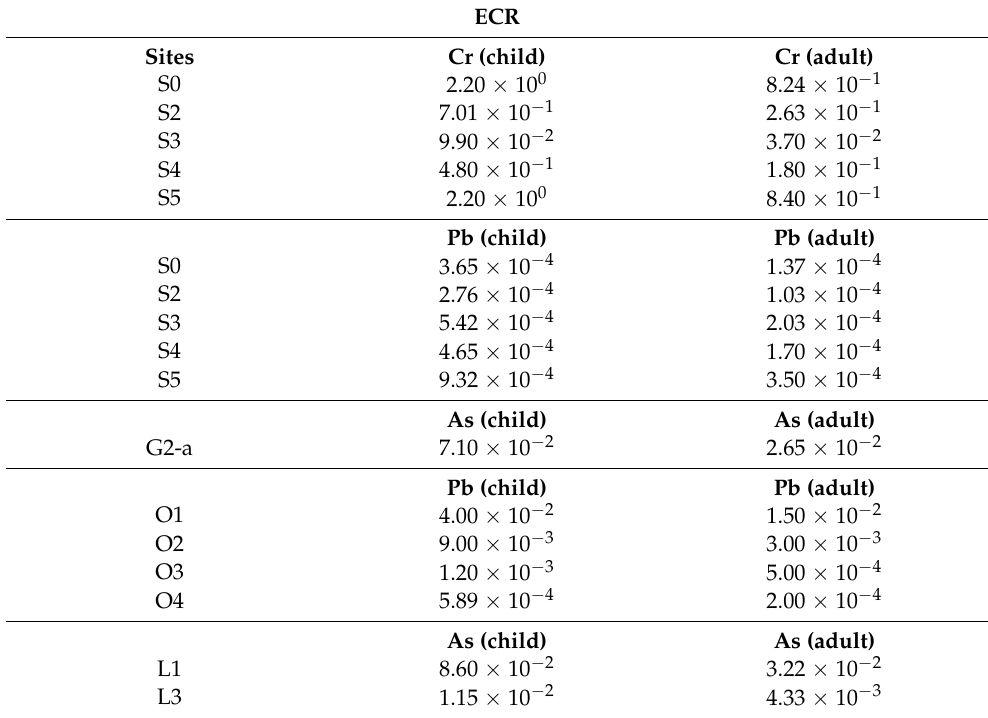
Table 2. Excessive risk for cancer